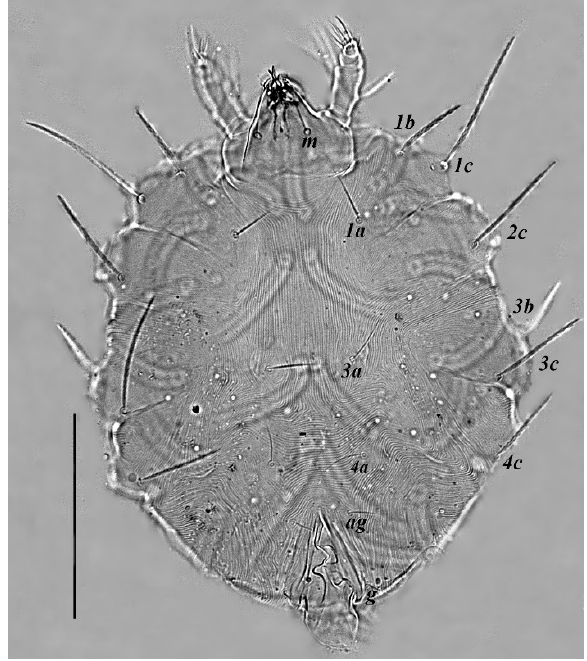
Figure 12. Neophyllobius fissus . Female. Venter. Scale bar: 100 μ m.